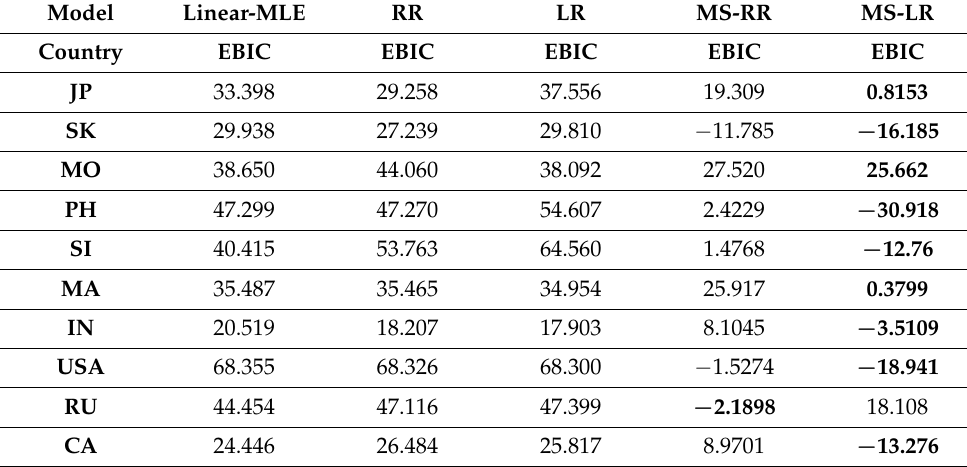
Table 3. Information criterion and model comparison.